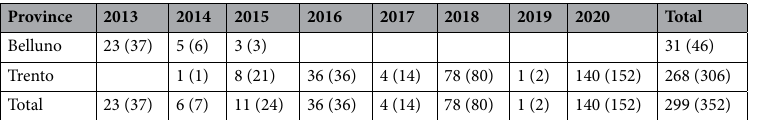
Table 1. Number of identified blood meals and engorged females (between brackets) by year and